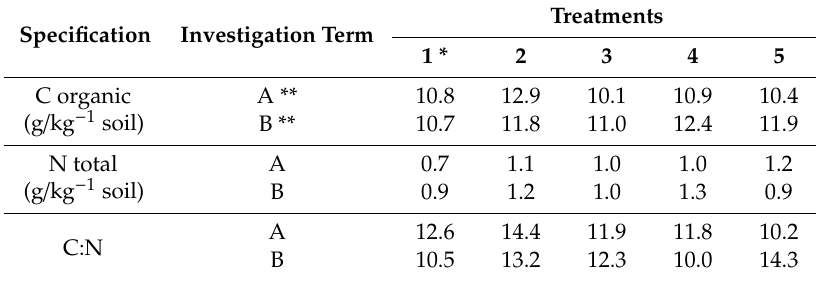
Table 3. Soil chemical properties (means for years